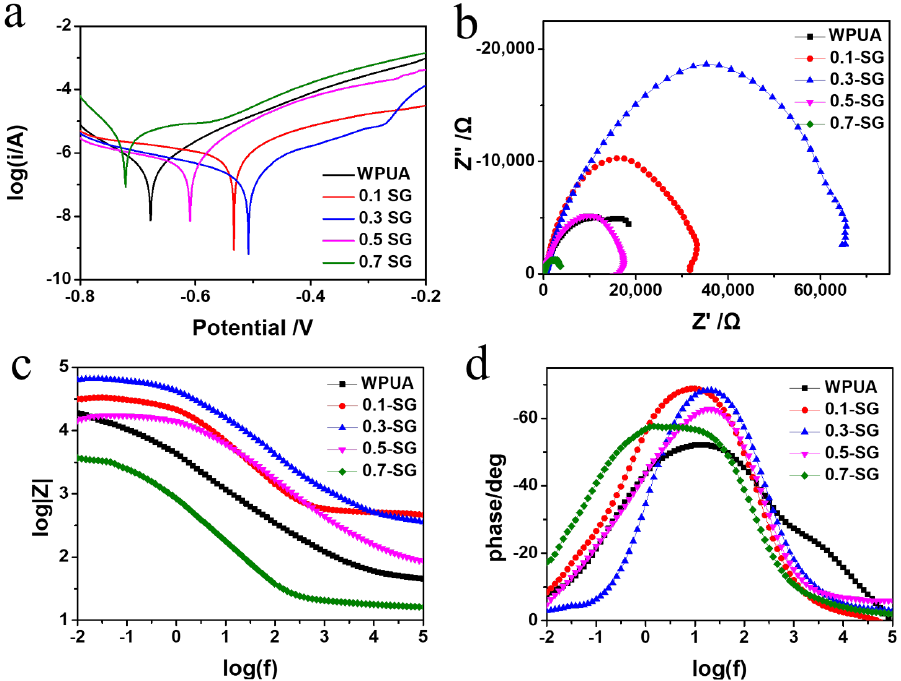
Figure 8. Tafel plots ( a ), Nyquist plots ( b ), Bode plots ( c ) and ( d ) of WPUA, 0.1-SG, 0.3-SG, 0.5-SG and 0.7-SG immersed in 3.5% NaCl aqueous solution. Table 2. Tafel electrochemical measurement data.